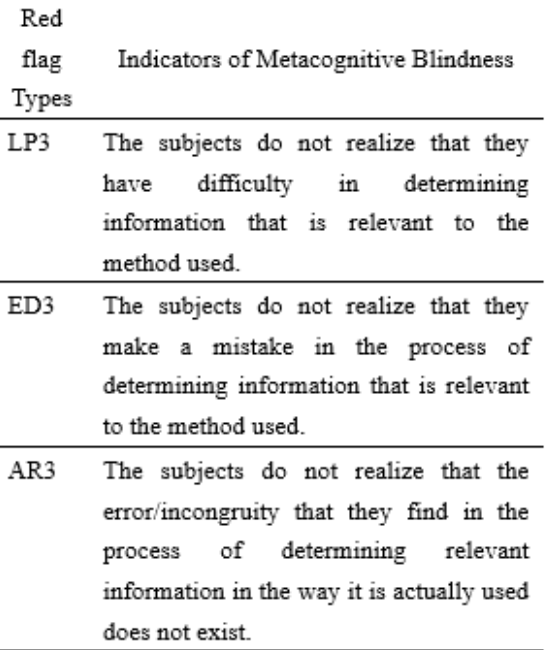
Table 5. Indicators of